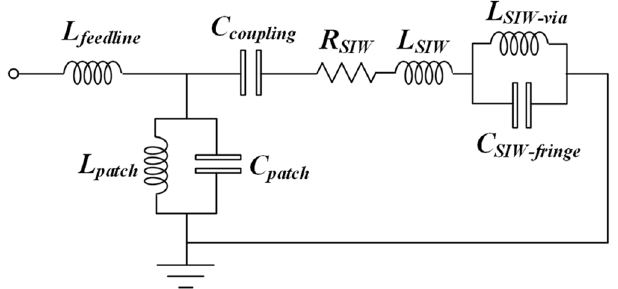
Figure 8. The simplified equivalent circuit of the SIW-loaded slotted